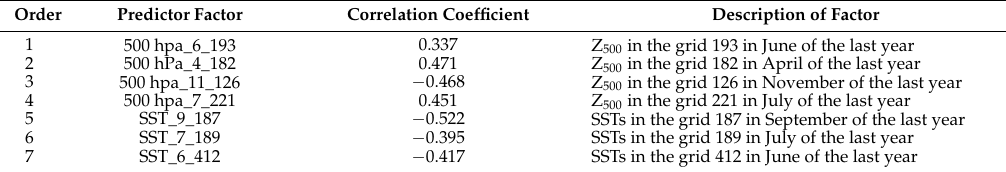
Table 2. Predictor factors used for annual shreamflow forecasting in the Danjiangkou Reservoir. Order Predictor Factor Correlation Coefficient